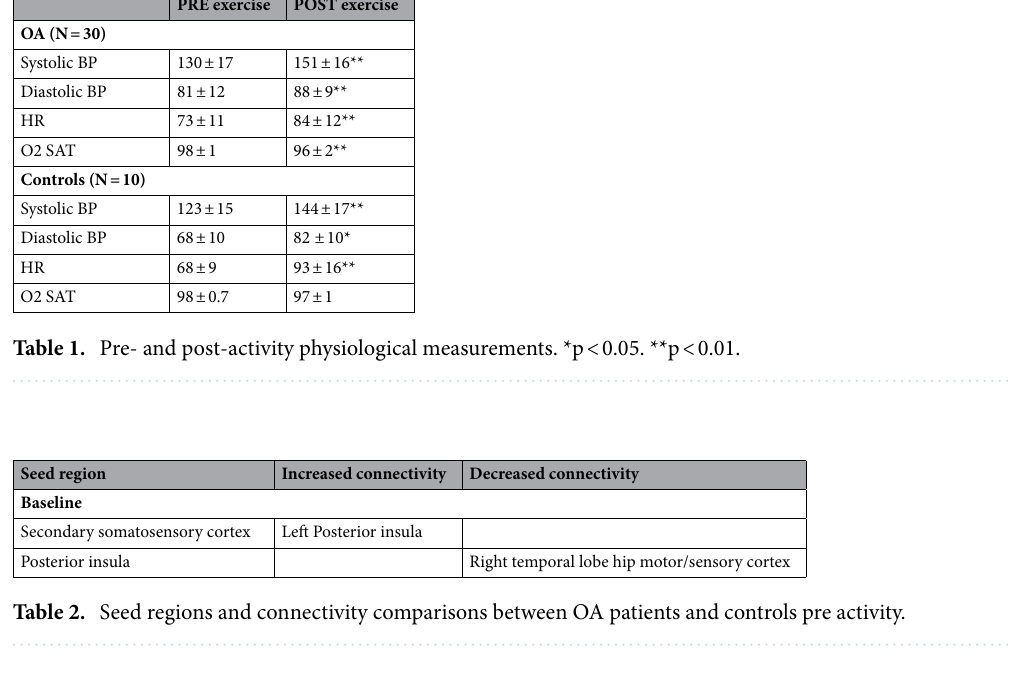
PRE exercise POST exercise